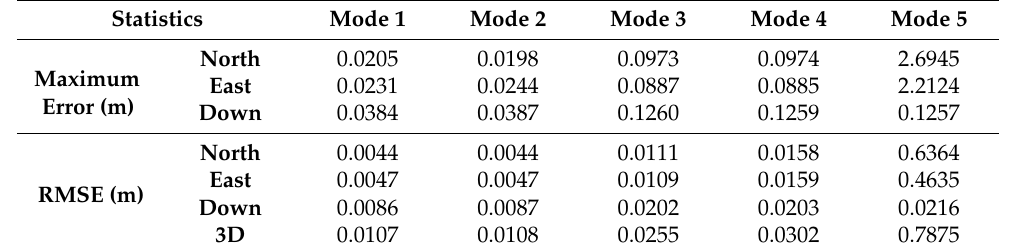
Table 3. Relative position errors in test 1.